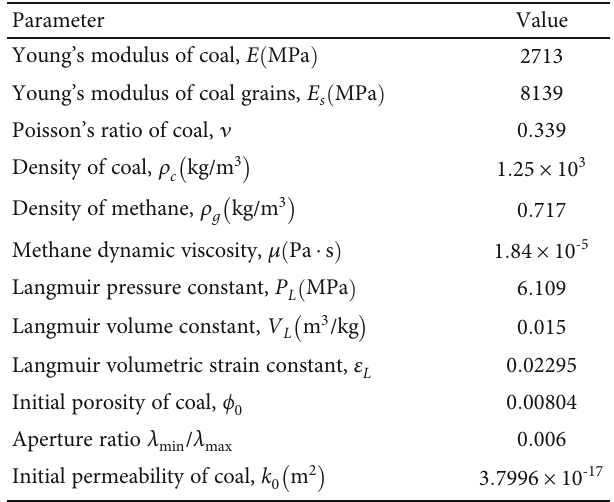
Table 2: Property parameters of coal and